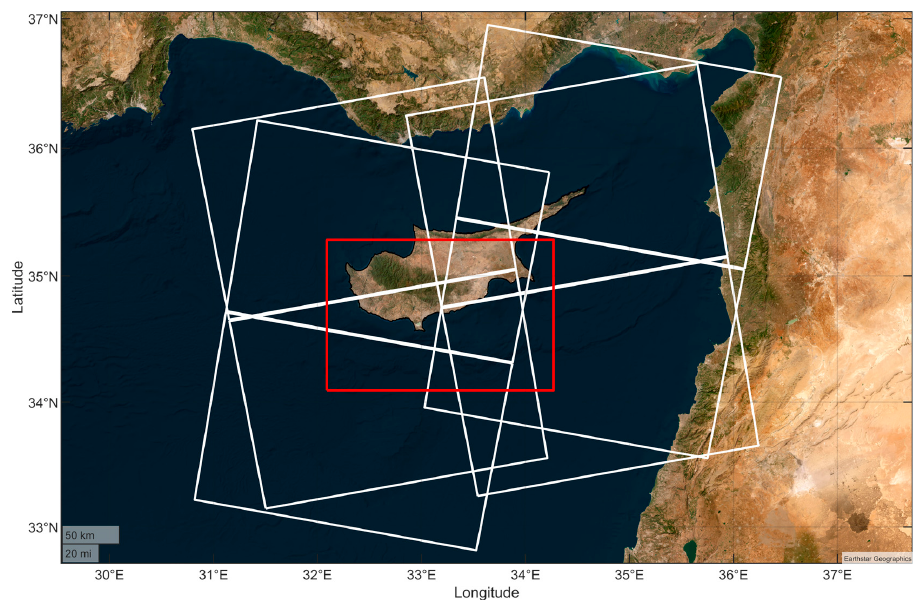
Figure 1. Outline of the study area (red polygon) and typical Sentinel tiles within a one-week period (white polygons). (Satellite base map is hosted by Esri).